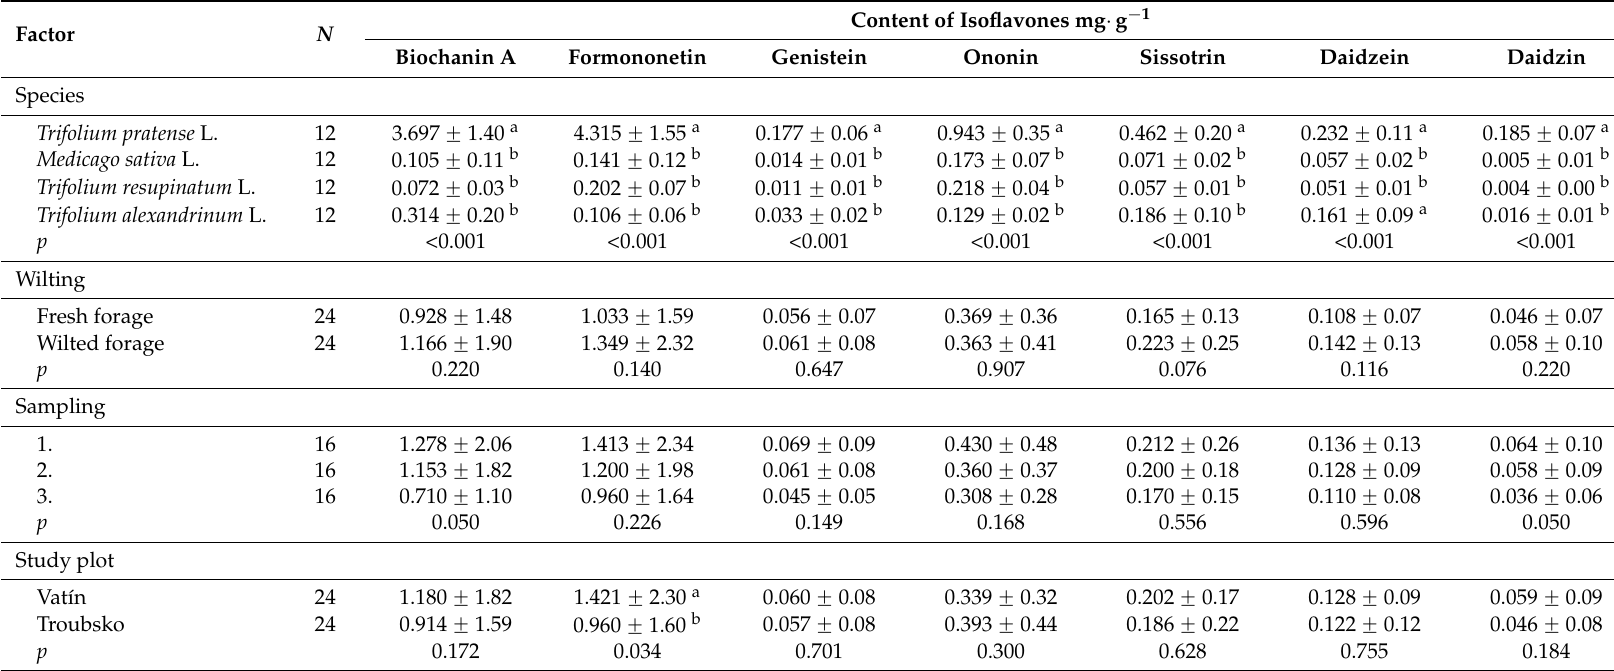
Table 2. Content of biochanin A, formononetin, genistein, ononin, sissotrin, daidzein, and daidzin in dry matter of Trifolium pratense , Medicago sativa , Trifolium resupinatum , and Trifolium alexandrinum (mg ¨ g ´ 1